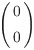
The liquid association coefficient (LAC).(a) Illustration of LAC using examples. Left column: dynamic correlation with an unknown conditioning factor. When the factor is low, x and y are negatively correlated; when the factor is high, x and y are positively correlated. Second left column: independent case. Right two columns: correlated case. In all the cases, the marginal distribution of X and Y are standard normal. (b) Empirical distributions of LAC score under conditions of dynamic correlation, simple correlation, or independence. The densities are based on 1000 simulations. In the dynamic correlation cases, one-third of the data points follow a bivariate normal distribution with mean (00) and variance-covariance matrix (1ρρ1), one-third follow a bivariate normal distribution with mean (00) and variance-covariance matrix (1−ρ−ρ1), and another one-third follow independent standard normal distributions. In the correlated case, all data points follow a bivariate normal distribution with mean (00) and variance-covariance matrix (1ρρ1).